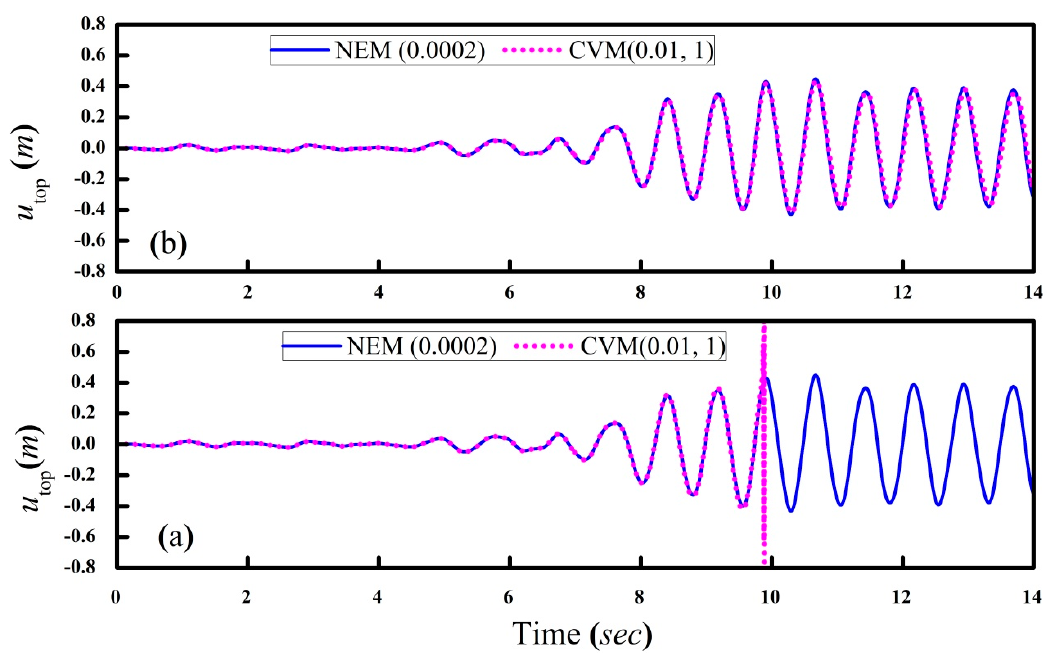
Figure 18. Seismic responses of the top-storey of the eight-storey building subjected to the earthquake record CHY028 ( a ) σ = 1.0 ( b ) σ = 2.0.